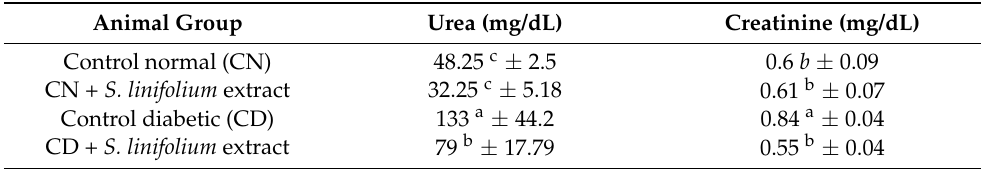
Table 5. Effect of phlorotannin extracts in the kidney function tests, represented by the urea (mg/dL) and creatinine (mg/dL) in the different treatment groups.